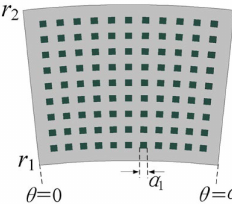
Figure 3. Uniform distribution of hexahedron textures ( r 1 is inner radius; r 2 is outer radius; α 1 is angle of a texture structure; θ is center angle; The dark area is textured area; The light-colored area is the non-textured